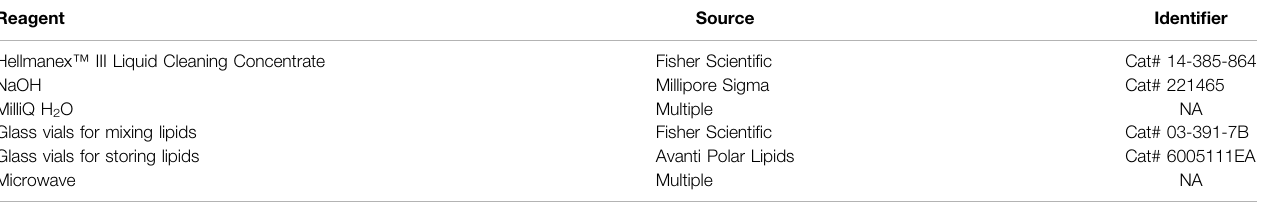
TABLE 1 | Reagents for cleaning glass vials. We have listed the speci fi c items we have used to perform theseassays. Many chemicals and supplieshave numerous options available from multiple companies.